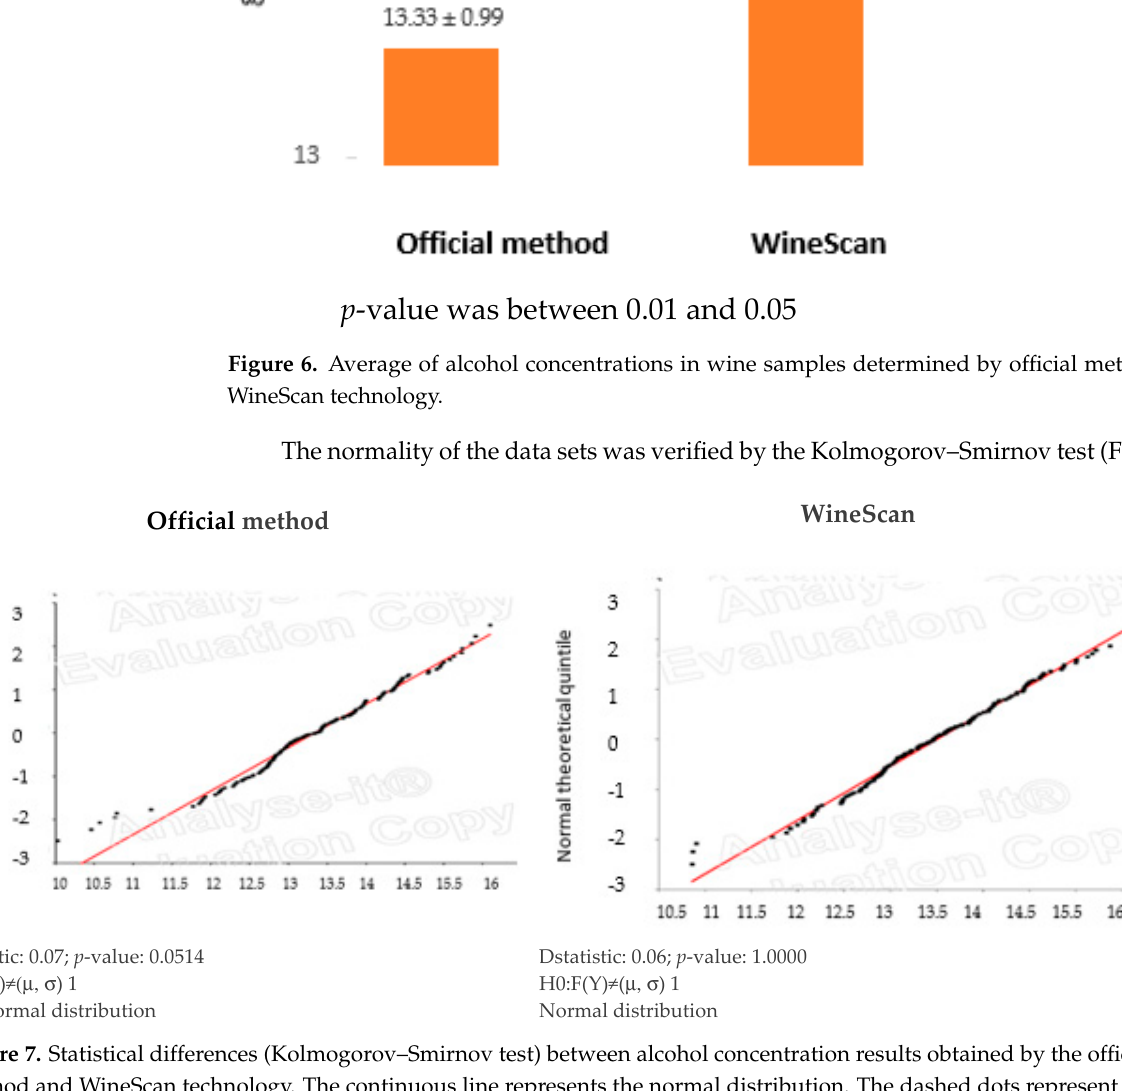
Figure 7. Statistical differences (Kolmogorov–Smirnov test) between alcohol concentration results obtained by the official method and WineScan technology. The continuous line represents the normal distribution. The dashed dots represent the observed distribution.